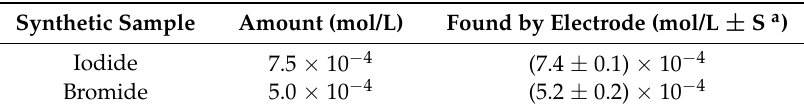
Table 4. Analytical applications of sensors from synthetic samples.